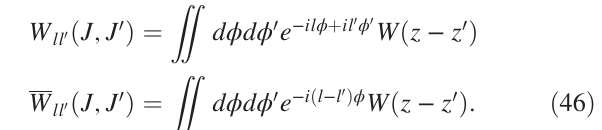
FIG. 16. Real part of eigenvector x mode as a function of J for σ mode, where ν ð J Þ is calculated with linear interpolation. In this case we x l consider the distortion of longitudinal phase space trajectory but keep the synchrotron tune constantly.